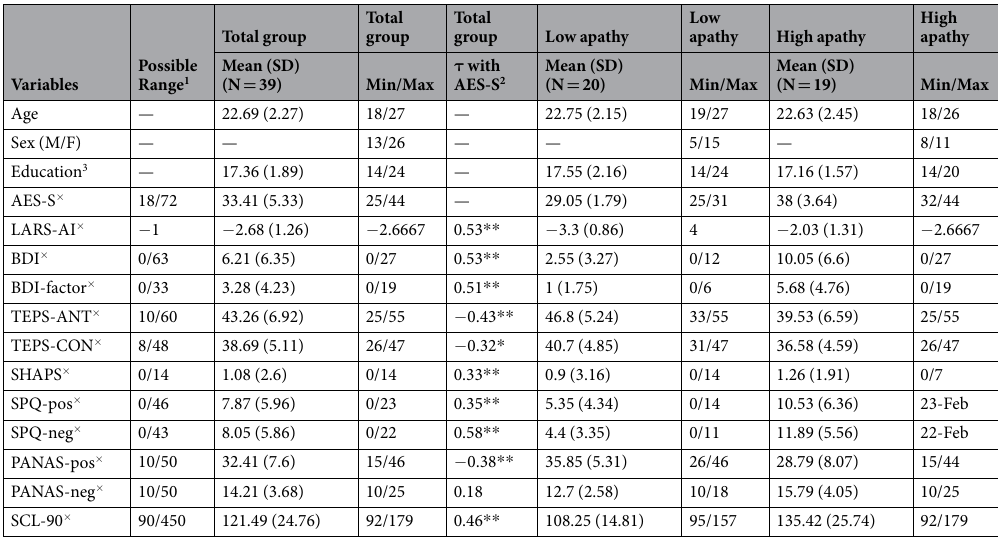
Table 1. Demographical information and mean scores on the questionnaires for the total group and separate for participants scoring low and high on apathy. * p < 0.05 is statistically significant. ** Significant after Bonferroni correction, p < 0.005. × Significant different means for low and high apathy groups, t-test, p < 0.05. AES-S = Apathy Evaluation Scale, Self-rated; BDI = Beck Depression Inventory; PANAS = Positive and Negative Schedule; LARS_AI = Lilly Apathy Rating Scale, Action Initiation subscale; SCL-90 =